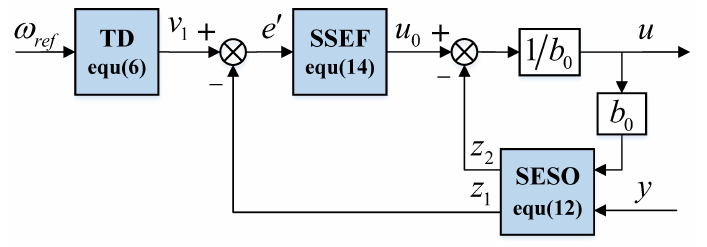
Figure 5. SADRC block